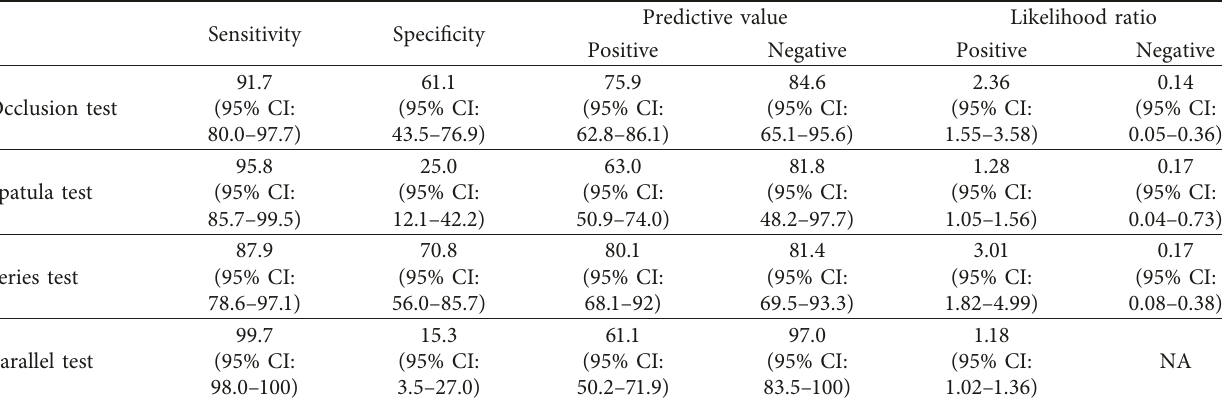
Table 4: Diagnostic value of the occlusion test, spatula test, and two tests combined (series test and parallel